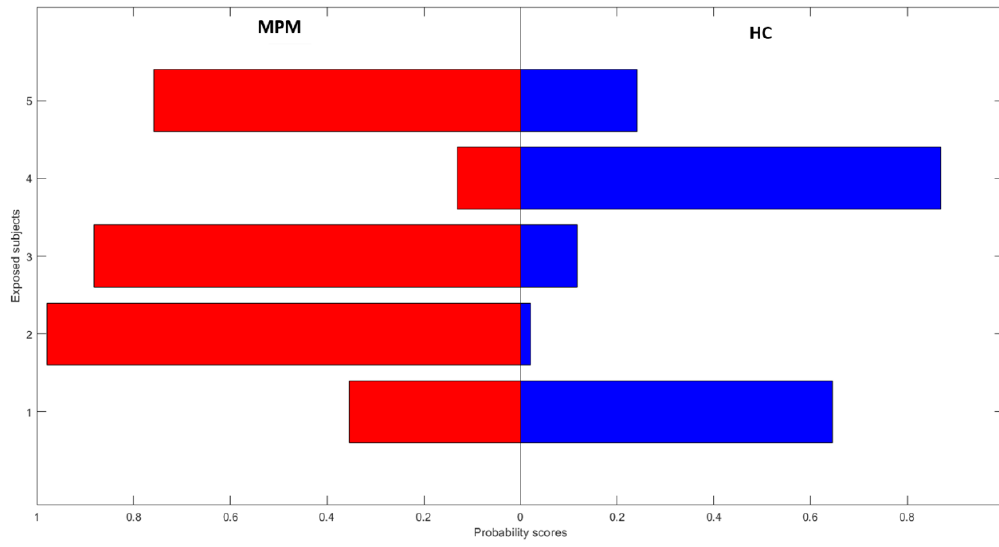
Figure 5. Probability scores for exposed subjects.